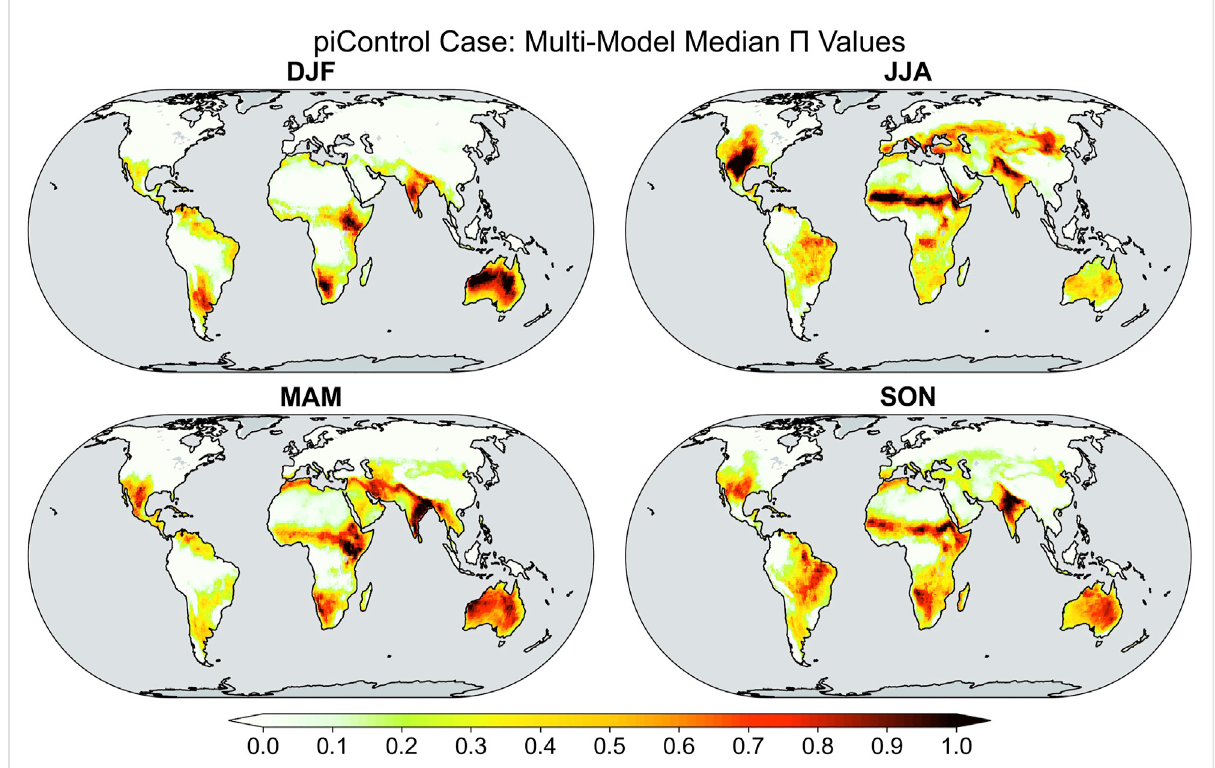
FIGURE 1 Multimodel median values of soil moisture – temperature coupling ( Π ; dimensionless) for each season from preindustrial control (piControl) simulations from CMIP6. Values are calculated over ice-free land areas